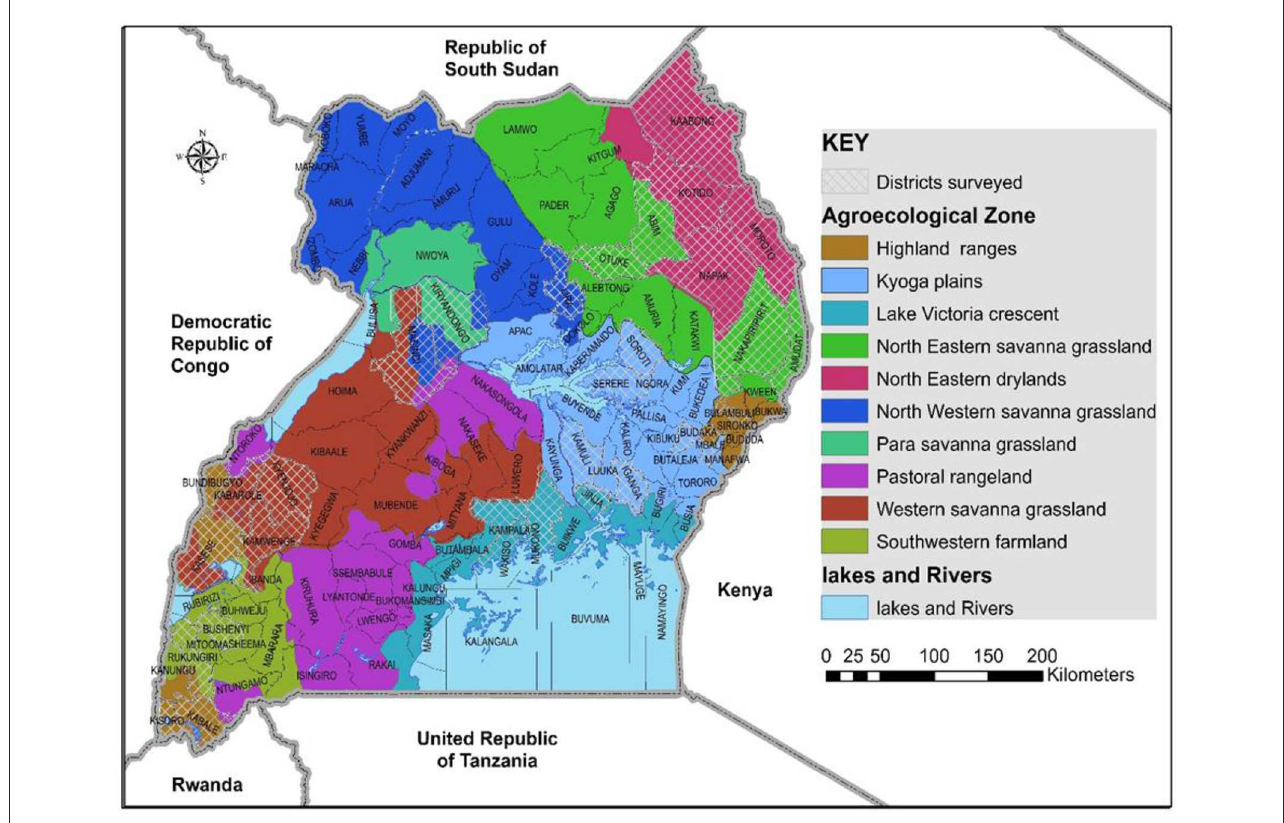
FIGURE1 Agro-ecological areas in Uganda where whiteflies were collected during May/August 2017 are shown by the white-mesh covered